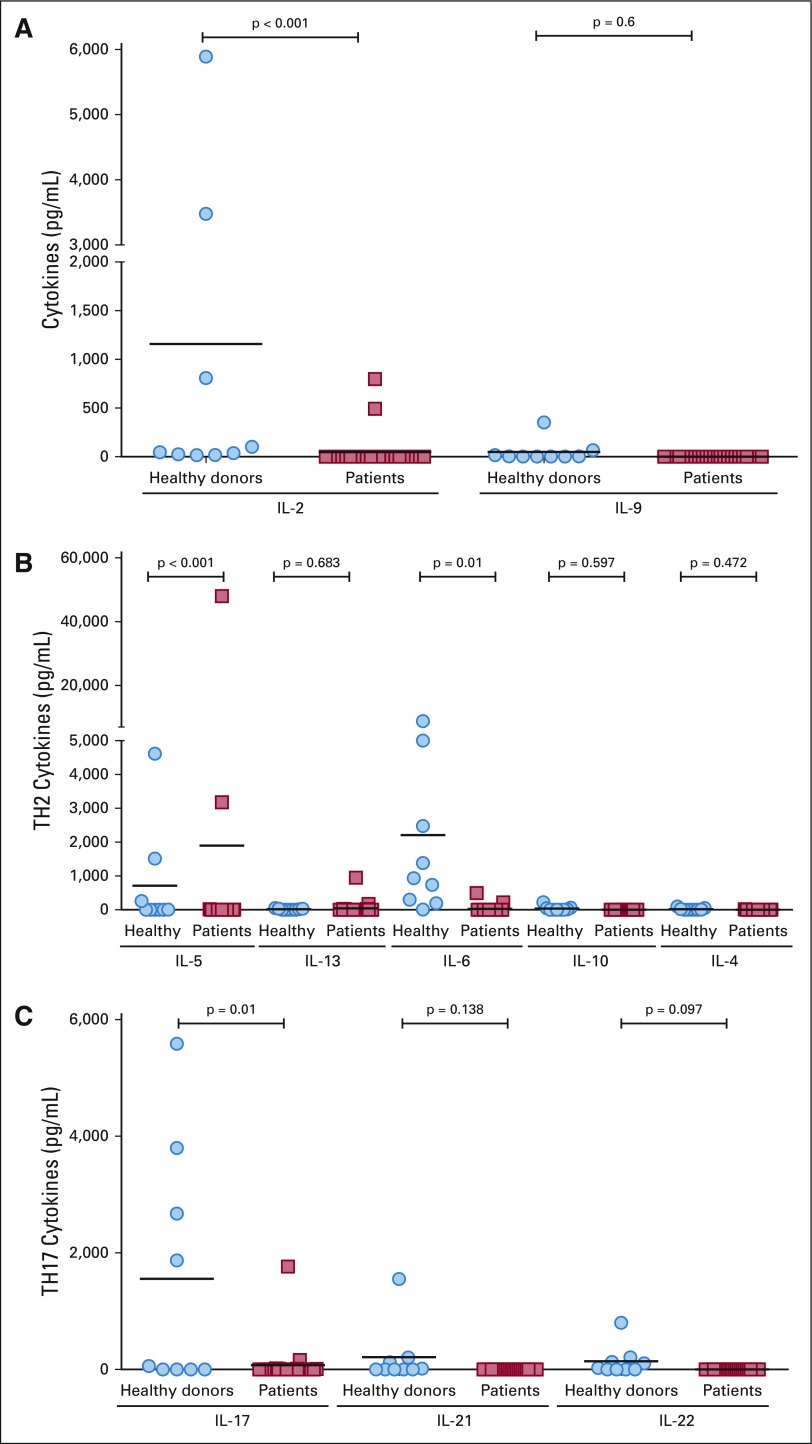
Expression of proinflammatory cytokines in healthy donors and patients with acute myeloid leukemia (AML). Release of proinflammatory cytokines IL-2, IL-5, and IL-6 were reduced in the patients with AML compared with healthy donors. (A) Concentrations of IL-2 and Il-9 in the supernatants of stimulated peripheral blood mononuclear cells (PBMCs) from all patients. (B) Concentrations of T helper 2 cells (Th2) cytokines in the supernatants of stimulated PBMCs from all patients. (C) Concentrations of Th17 cytokines in the supernatants of stimulated PBMCs from all patients.